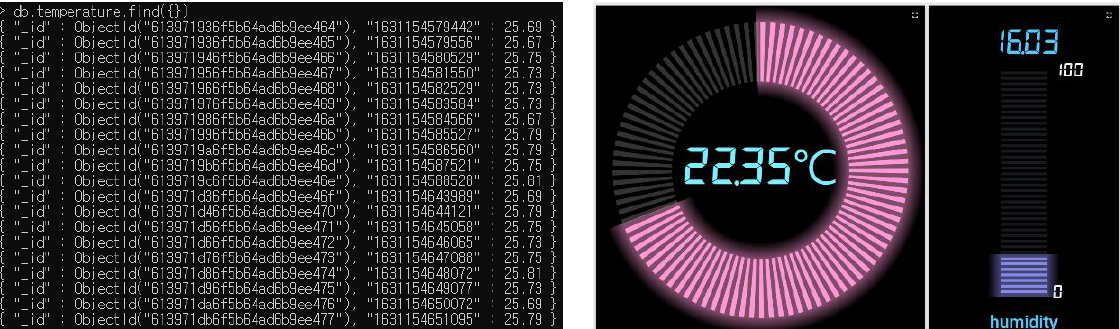
Figure 10. First dashboard screen captured. (For your information, In this figure, the non-English term “ 평균 ” means “ average ” in English) .